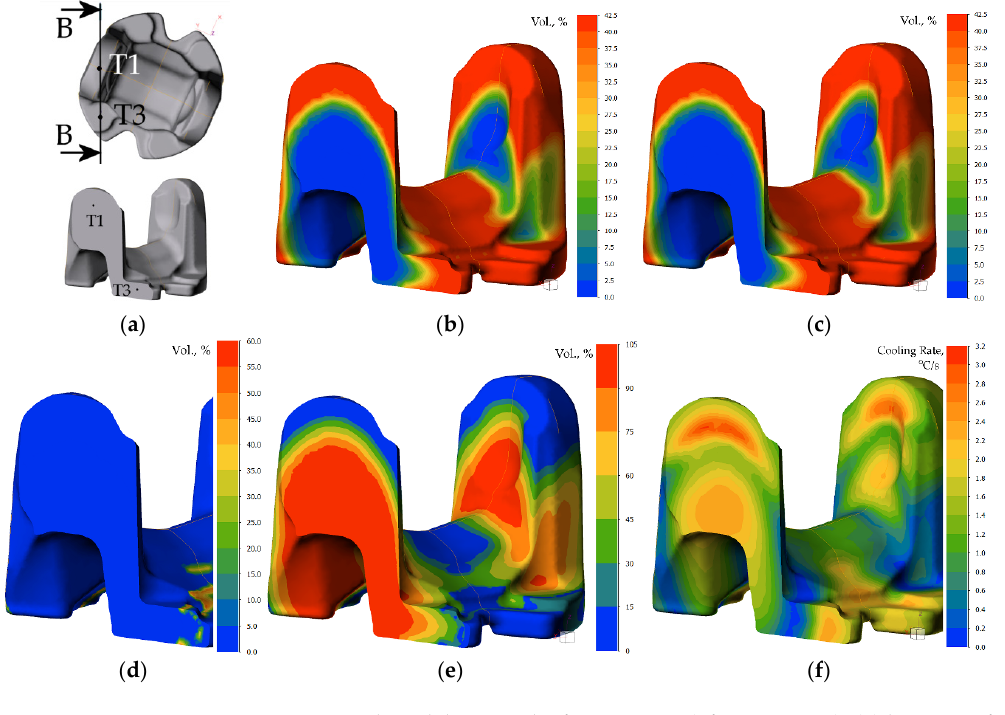
Figure 16. Numerical modeling results for time 60 s (after sprayer1): ( a ) location of cross-section in plane of points T1 and T3, and calculated volume fractions of: ( b ) ferrite, ( c ) pearlite, ( d ) bainite, and ( e ) austenite (untransformed). ( f ) Instant cooling rate.